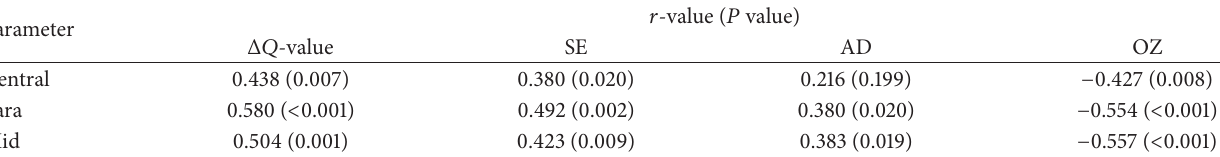
Table 2: The correlation between Δ CET and Δ𝑄 -value, SE, and AD 6 months postoperatively.